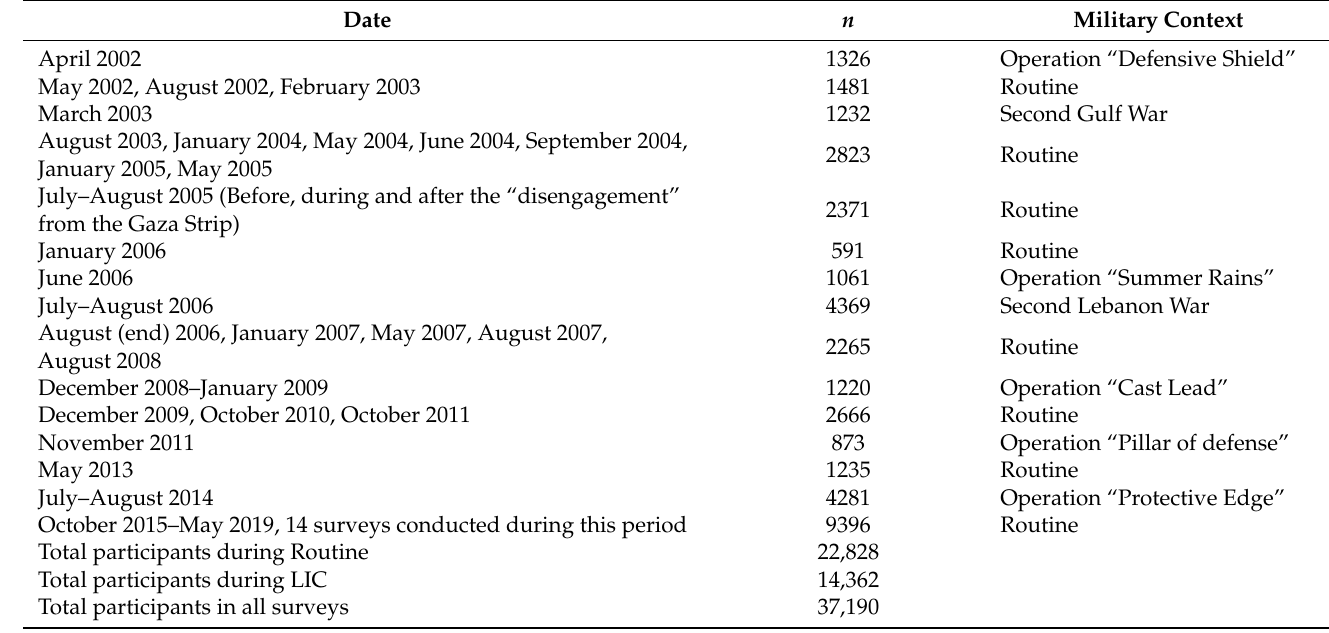
Table 1. List of surveys by dates, number of participations and LIC